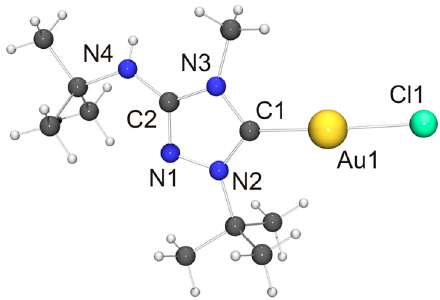
Figure 8. Molecular structure and aggregation of [AuCl( 6 ′ )] in the crystal. Selected bond lengths [Å] and angles [°]: C1 ‒ Au1 1.975(7), C1 ‒ N2 1.342(8), C1 ‒ N3 1.370(9), C2 ‒ N1 1.311(8), C2 ‒ N3 1.363(8), C2 ‒ N4 1.359(9), N1 ‒ N2 1.362(7), Au1 ‒ Cl1 2.2874(16); N2 ‒ C1 ‒ N3 103.3(6), C1 ‒ Au1 ‒ Cl1 176.3(2).